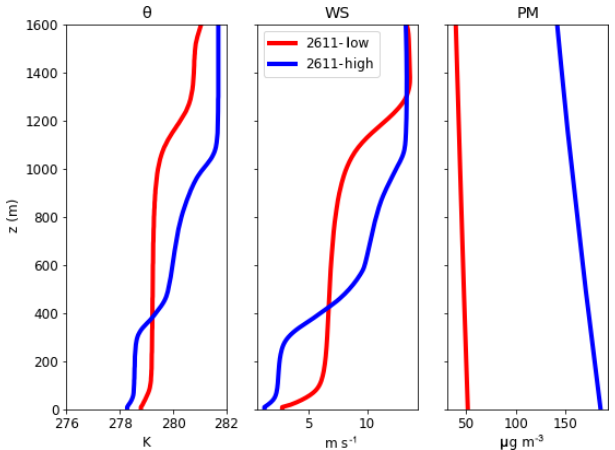
Figure 6. Potential temperature ( θ ), wind speed (WS) and aerosol mass concentration (PM) profiles on 26 November for low (red) and high (blue) aerosol concentrations at 17:00LST (9h of simulation).